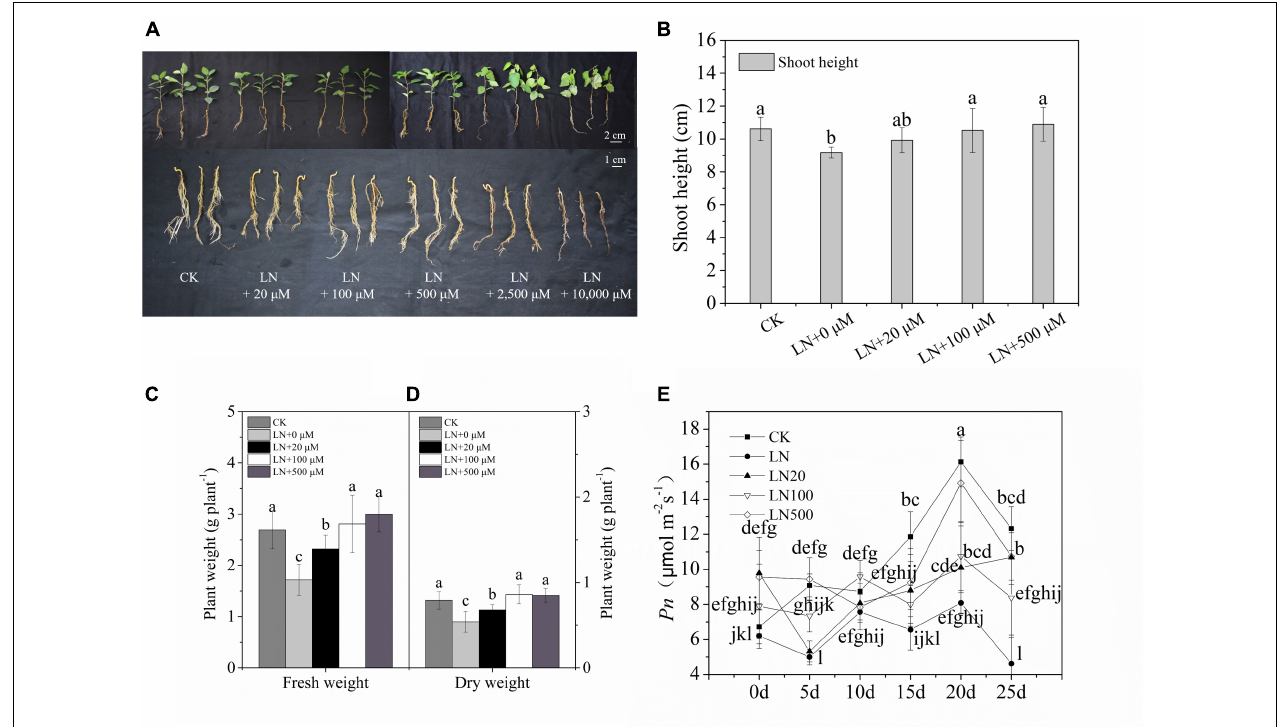
FIGURE 1 | Effect of N deficiency on the growth parameters of Malus hupehensis . Whole plant and underground phenotypes (A) , shoot height (cm) (B) , fresh weight (g − 1 plant) (C) , dry weight (g − 1 plant) (D) , and net photosynthetic rate ( Pn ) (E) from 0 to 25 days every 5 days. CK, half-strength nutrient solution; LN, N-deficiency treatment; LN + 20 µ mol L − 1 , N-deficiency treatment plus 20 µ mol L − 1 arginine; LN + 100 µ mol L − 1 , N-deficiency treatment plus 100 µ mol L − 1 arginine; LN + 500 µ mol L − 1 , N-deficiency treatment plus 500 µ mol L − 1 arginine; LN + 2500 µ mol L − 1 , N-deficiency treatment plus 2500 µ mol L − 1 arginine; and LN + 10000 µ mol L − 1 , and N-deficiency treatment plus 10000 µ mol L − 1 arginine. The picture was taken on the third d of the experiment). Values are means of ten replicates ± SD. Values not represented by the same letter are significantly different according to Tukey’s multiple-range test ( P < 0.05).